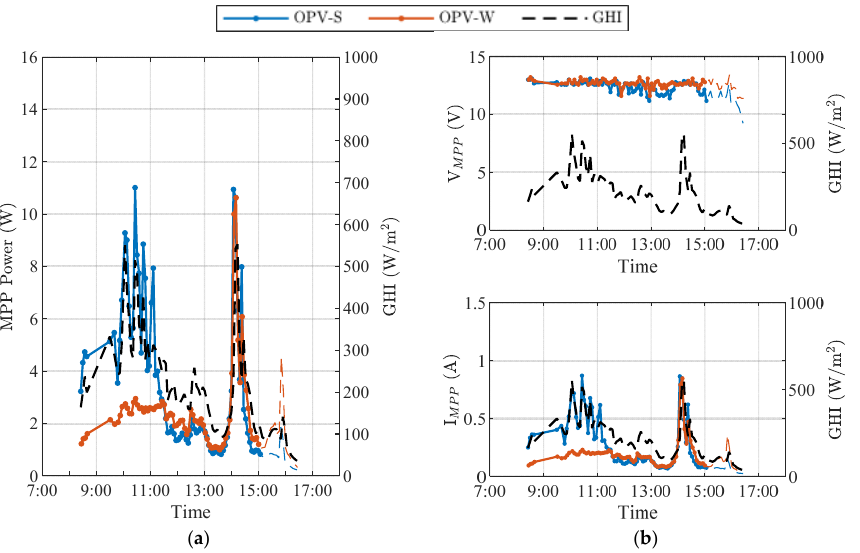
Figure 13. Example of raw data on a partially cloudy day: ( a ) maximum power, P mpp ; ( b ) its coordinates, V mpp and I mpp , recorded on 11 February 2021.